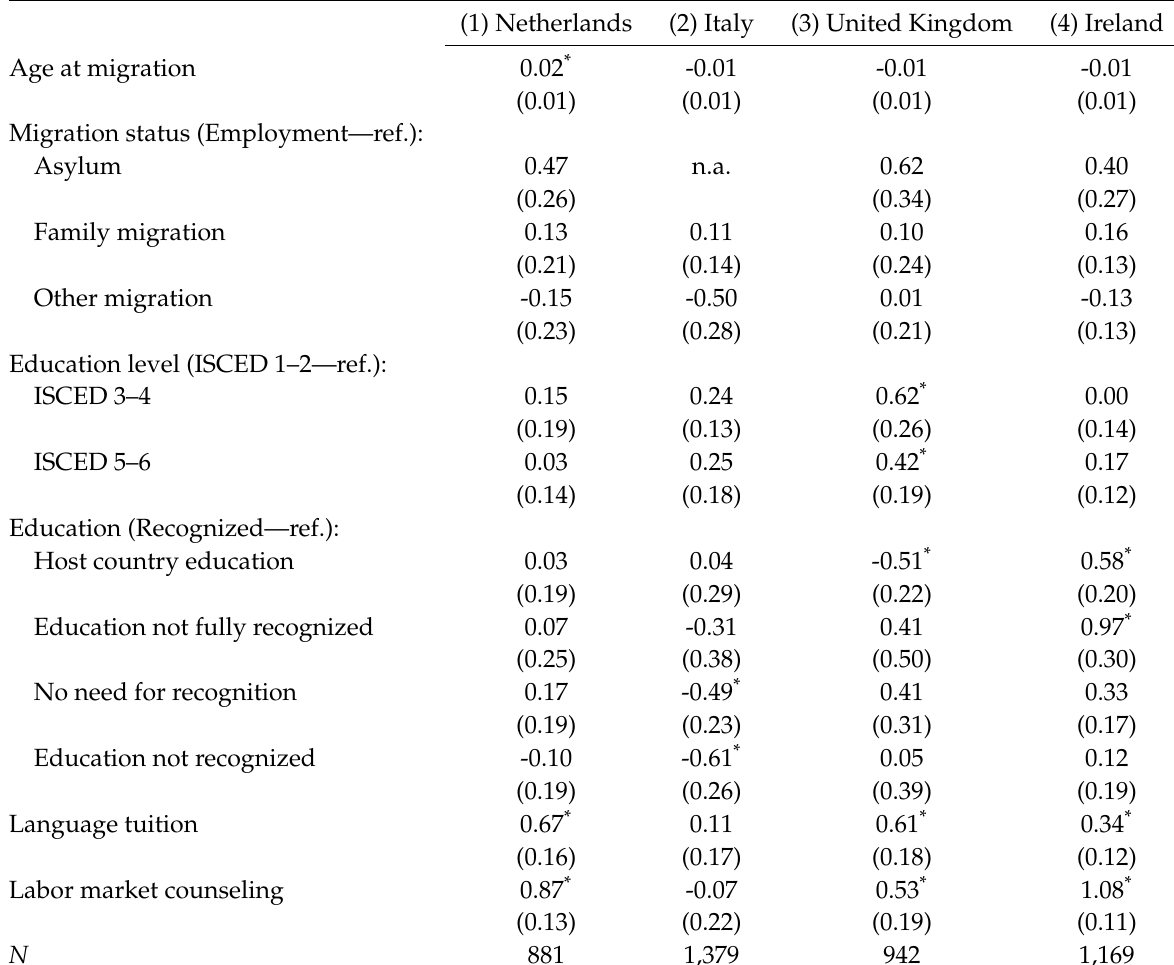
Table 1: Selected Predictors of Participation in Training (Results of the Probit Regression from the PSM